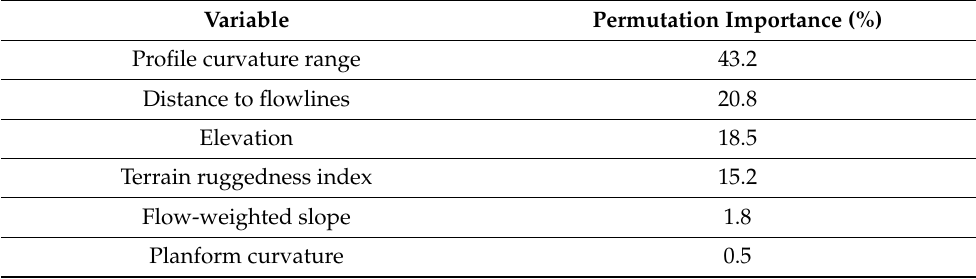
Figure 7. Predicted prevalence of seeps and springs in the entire study area. Seeps and springs are most likely to occur where spring prevalence values are highest. The inset highlights the small box in the southeast of the study area, which is an example area where the probability of the occurrence of seeps and springs is particularly high. Table 2. Permutation importance for variables used to predict seeps and springs using the Maxent